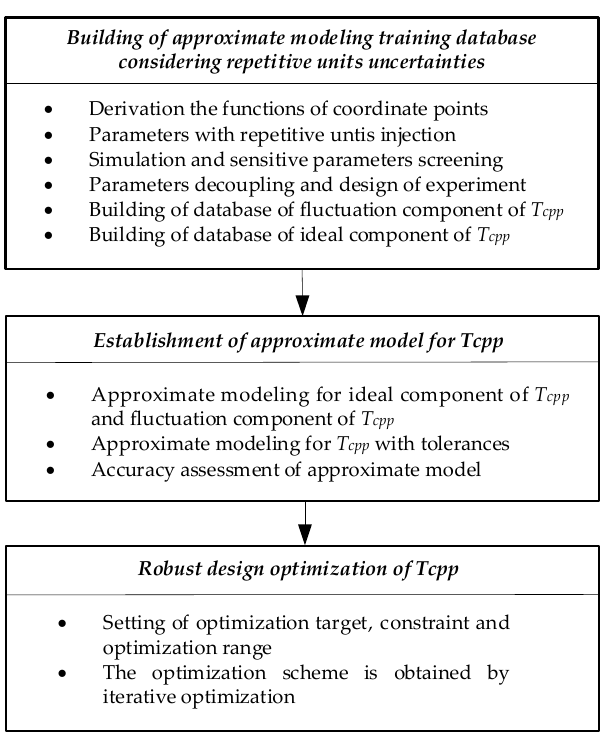
Figure 2. The procedure of the proposed approach.